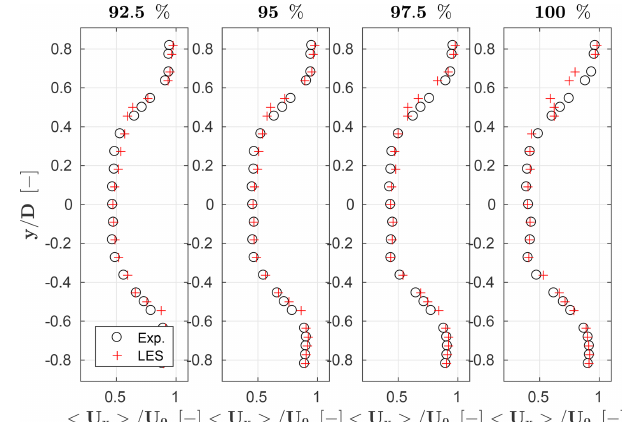
Figure 6. Normalized time-averaged streamwise velocity (cid:104) u x (cid:105) /U 0 profiles at 100% and 92.5% power settings, measured at hub height and 4D downstream of the rotor. Red + symbols: LES; black ◦ symbols: experimental results.